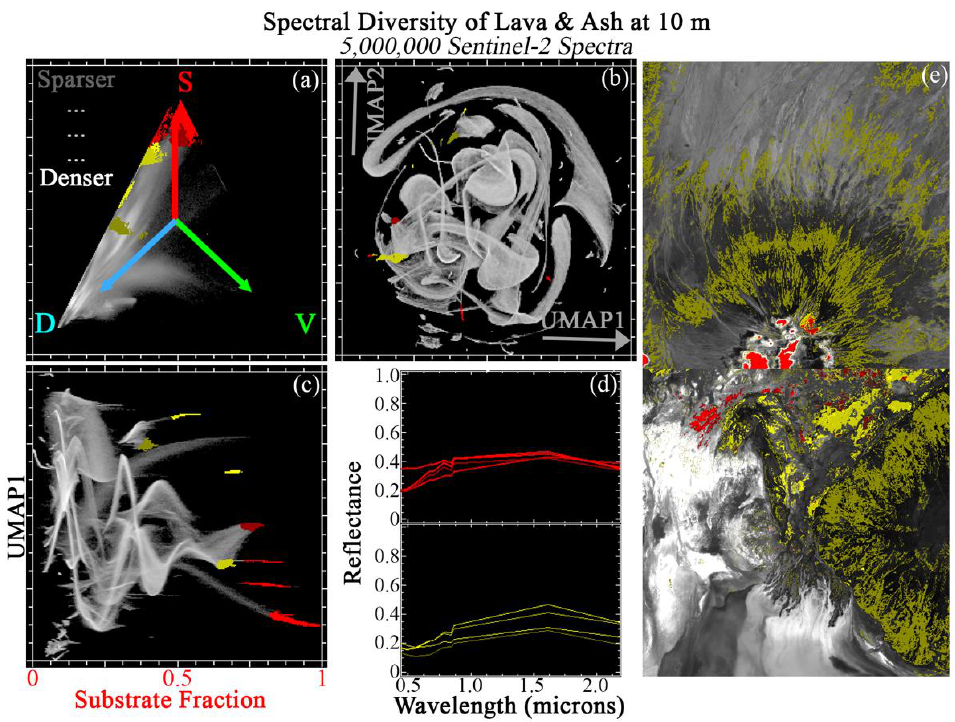
Figure 6. Joint characterization of lava and ash. 5 × 1 megapixel Sentinel-2 tile subsets are selected from global volcanic hotspots and analyzed at full 10 m pixel resolution. These spectra preferentially occupy the S to D apexes of the SVD mixing space ( a ), leaving the V portion of the space relatively sparse. The global 3-endmember linear mixture model fits these spectra less well than the agricultural spectra (here, 96.5% of spectra with <5% RMSE). UMAP ( b ) captures both subtle mixing continua and discrete clusters, but does not offer physical interpretability. Joint characterization ( c ) uses the physical meaning of the Substrate mixture fraction to contextualize the subtle statistical relation- ships captured by UMAP. Example regions of interest are identified from the joint space and pro- jected onto the ternary mixing and UMAP spaces. Mean spectra for each region ( d ) illustrate simi- larities and differences among statistically distinct clusters. Clusters identified by joint characteri- zation also frequently show geographic coherence ( e ).